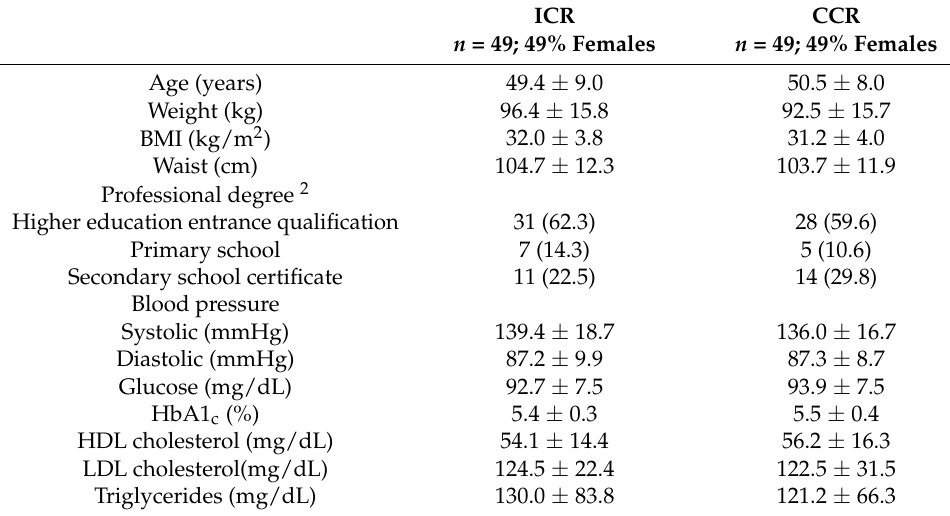
Table 1. Baseline characteristics of the study population 1